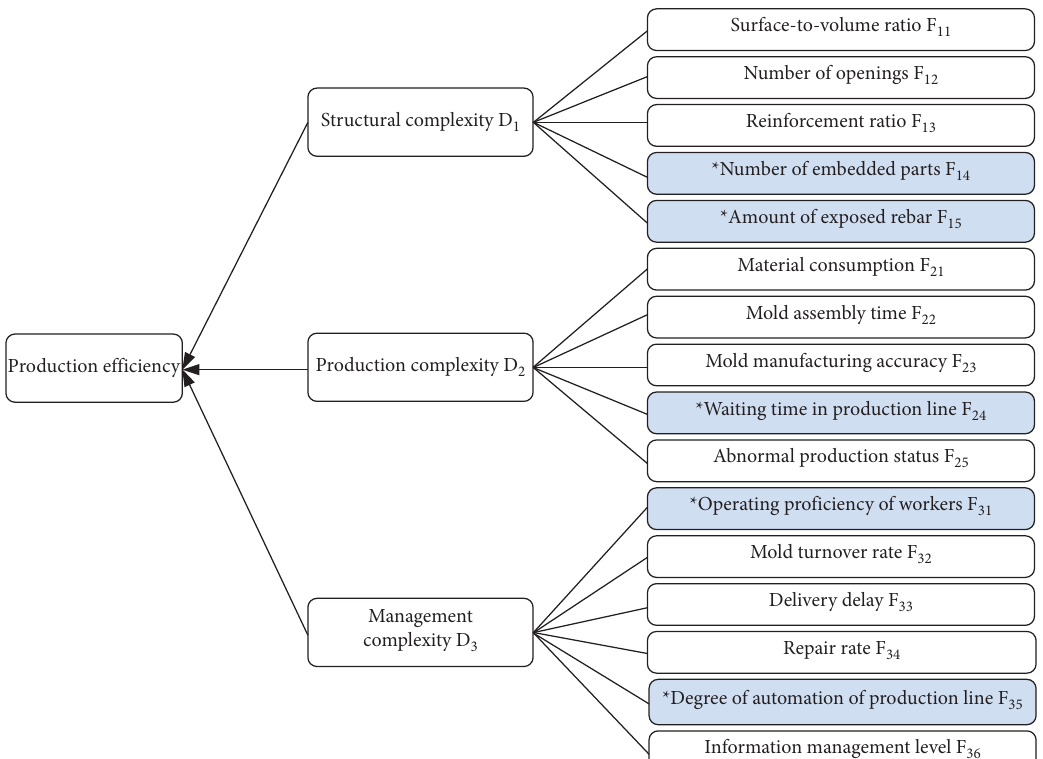
Figure 5: Relationship between complexity indices and production efficiency. Note: ∗ denotes the top five influence complexity